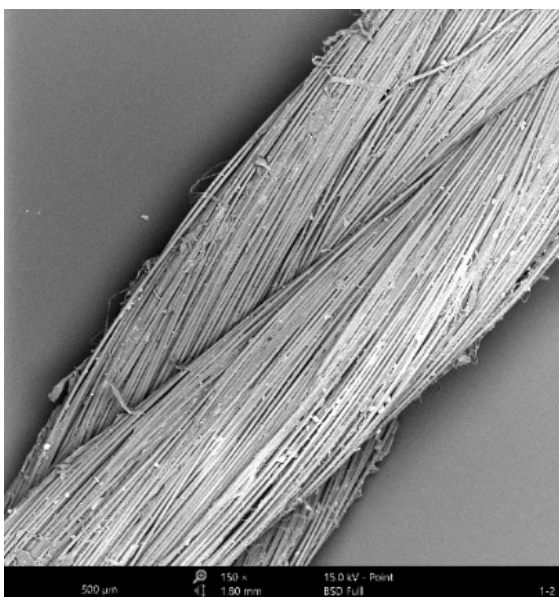
Figure 3. Multi-level structure diagram of Kevlar fiber.